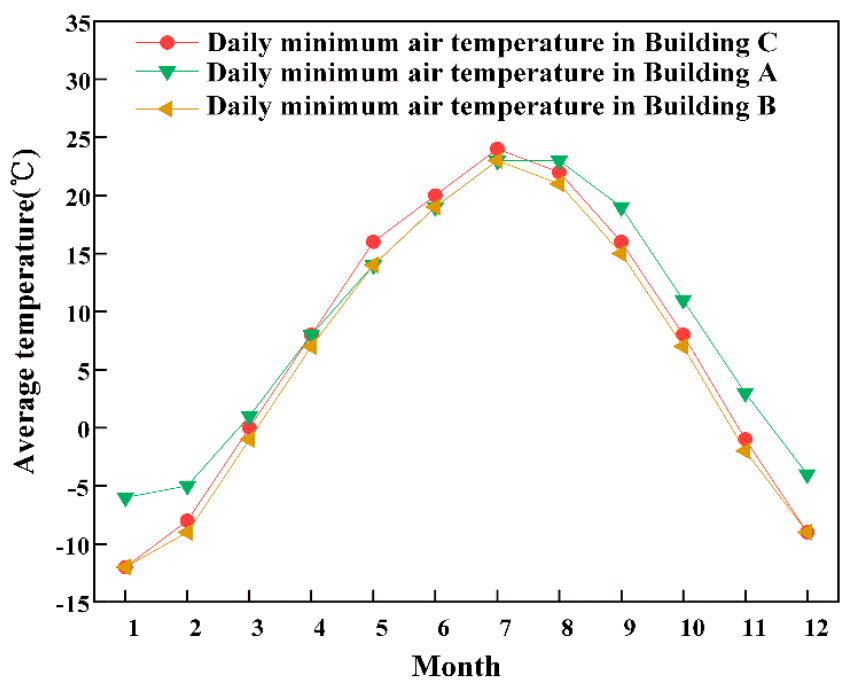
Figure 4. Daily minimum air temperature for three cities. The energy consumption monitoring platforms of Buildings A, B, and C are listed in Table 2. Table 2. Basic information on building energy consumption monitoring platforms.